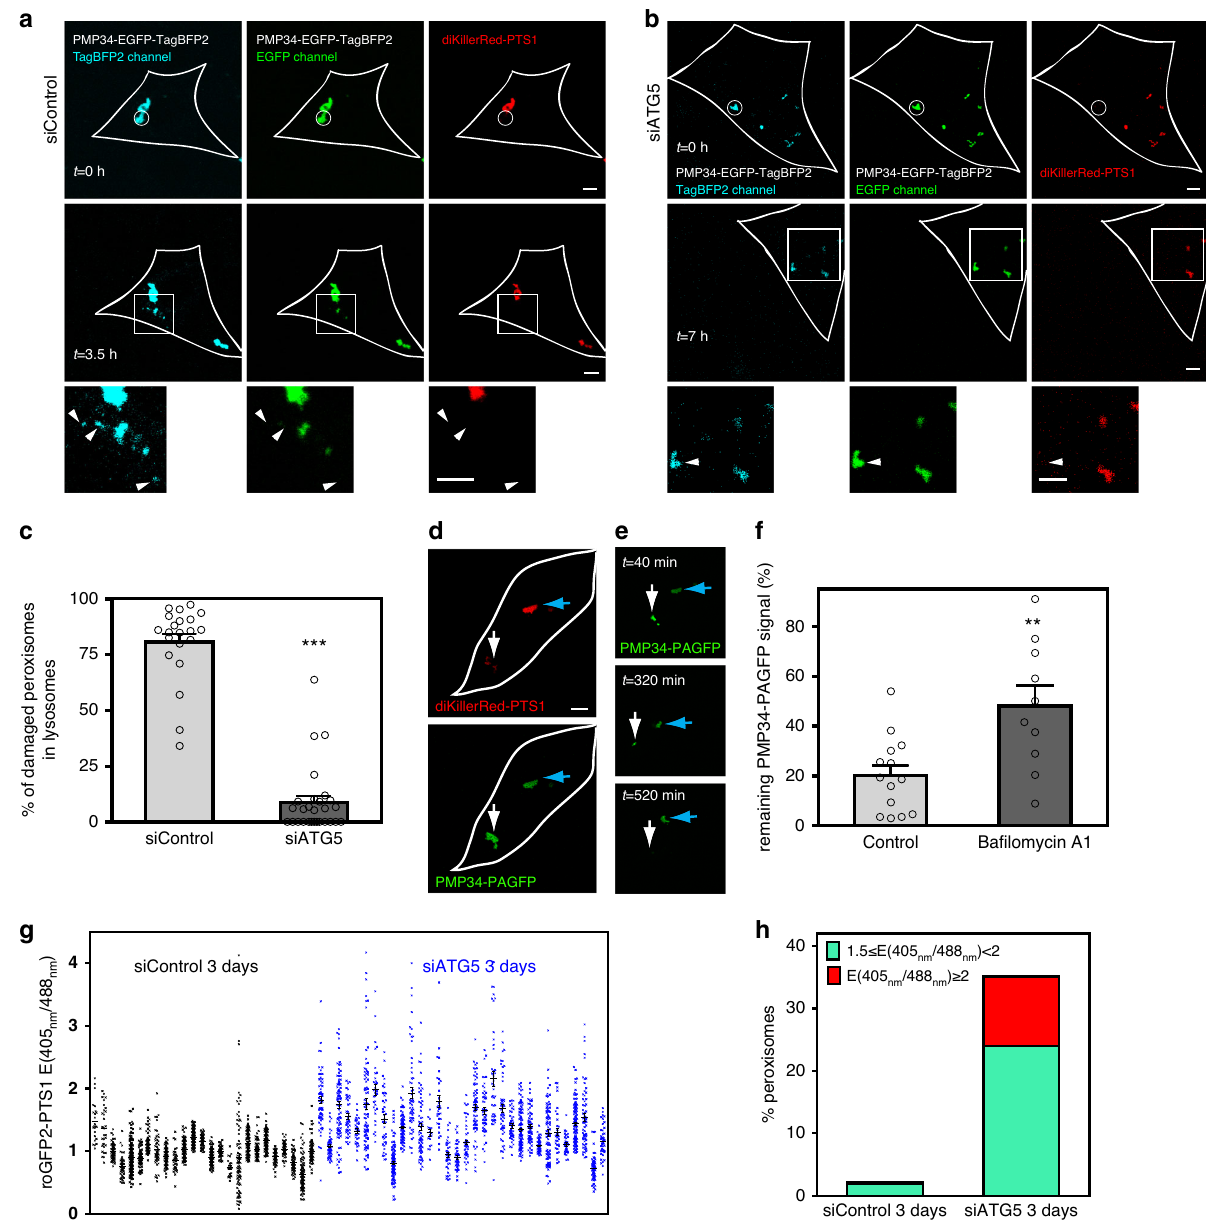
Fig. 2 ROS-stressed peroxisomes are removed by macroautophagy. a Peroxisomes within the white circular region in a NIH3T3 cell expressing PMP34- EGFP-TagBFP2 and diKillerRed-PTS1 were illuminated with 559 nm light (top panels). Middle panels: the same cell 3.5 h after illumination. Bottom panels: magni fi ed view of the white square region in the middle panels. The white arrows indicate the eventual loss of EGFP fl uorescence on damaged peroxisomes. b The experiment in a was similarly carried out on a NIH3T3 cell transfected with a siRNA targeting ATG5. c The percentage of